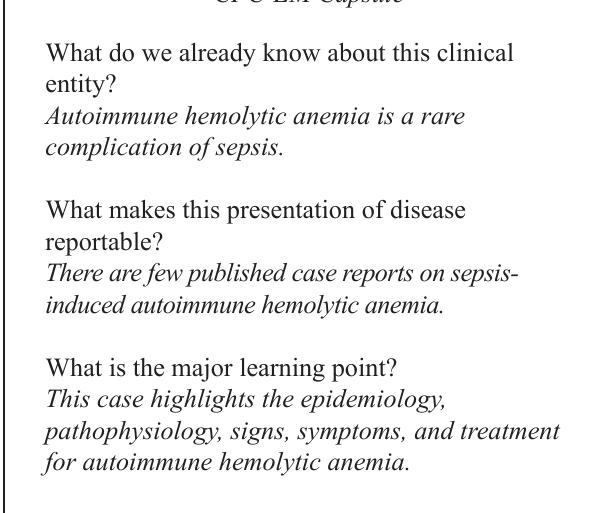
Table. Patient’s laboratory data upon diagnosis of warm autoimmune hemolytic anemia.